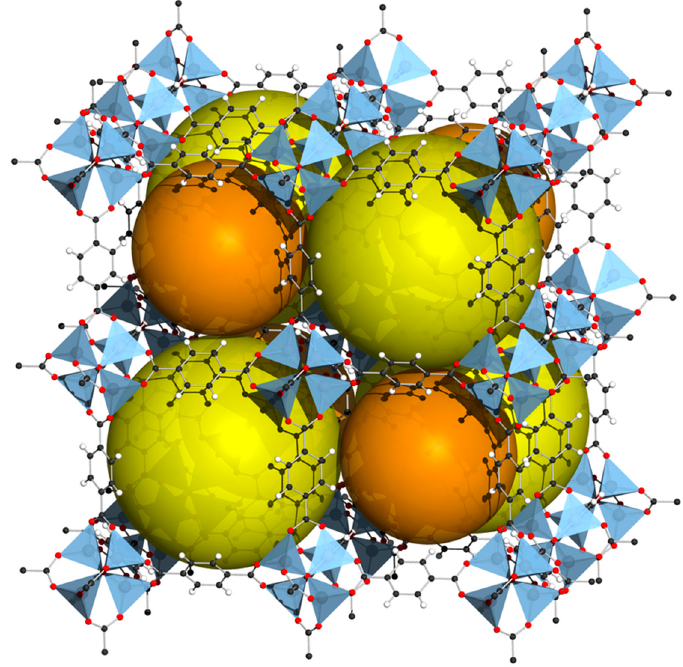
Figure 3. Crystal structure of MOF-5. Reprinted from Ref. [106]; Copyright Wikipedia 2018.